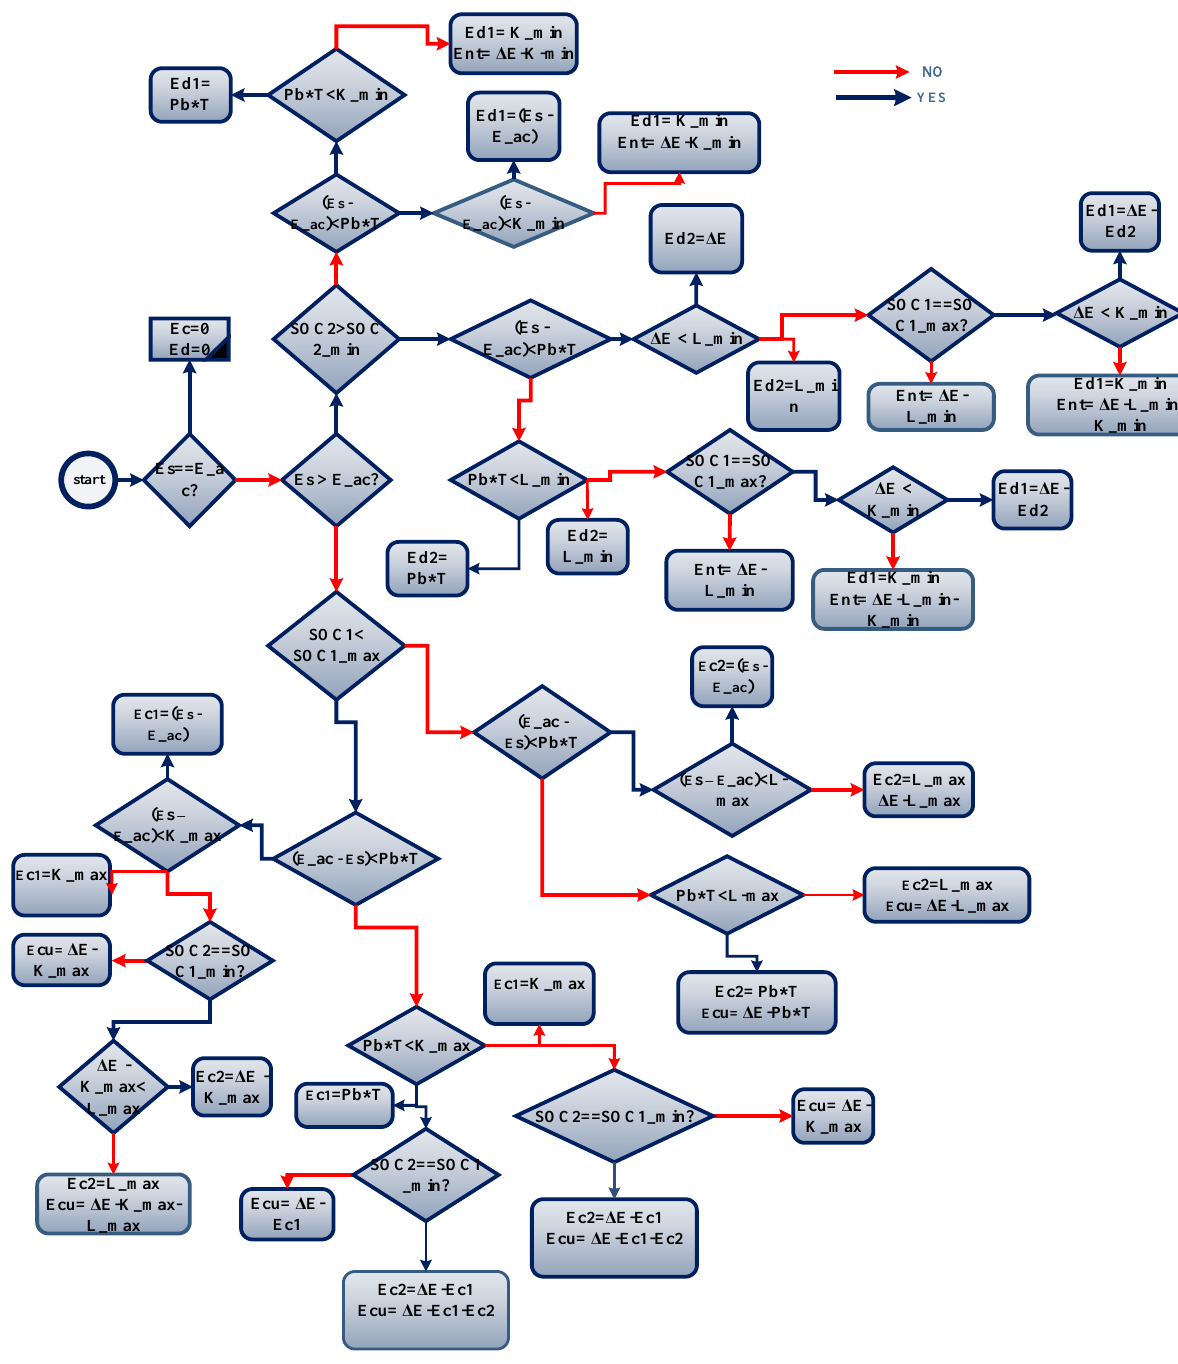
Figure 7. Control algorithm of asynchronous state exchanging strategy.